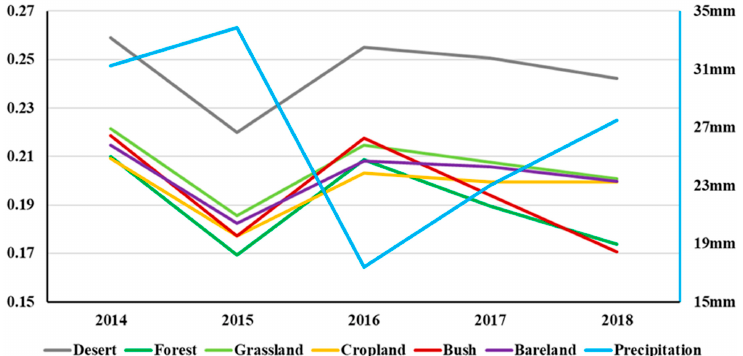
Figure 11. Relationship between average albedo of different land cover types and precipitation.